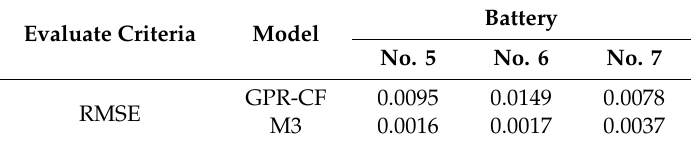
Table 4. Comparison of di ff erent SOH prediction models for three